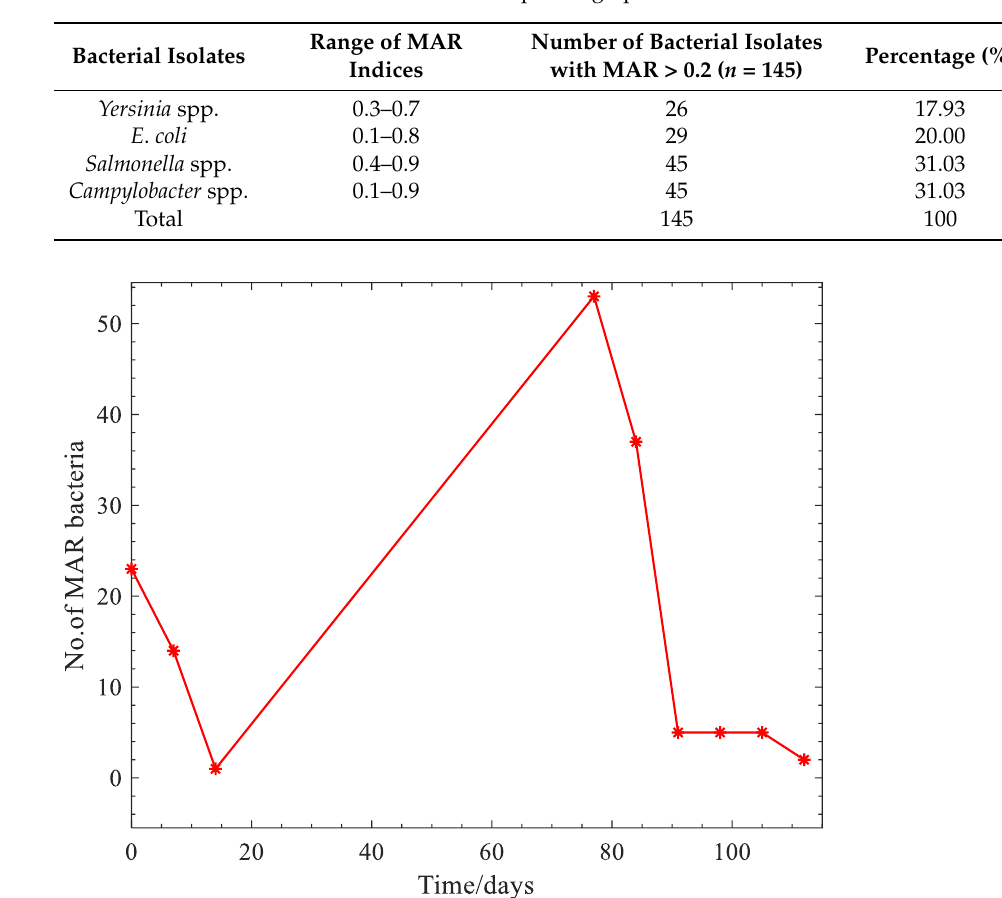
Table 2. Distribution of the bacterial isolates depending upon MAR > 0.2. Number of Bacterial Iso- Range of MAR In- Bacterial Isolates dices